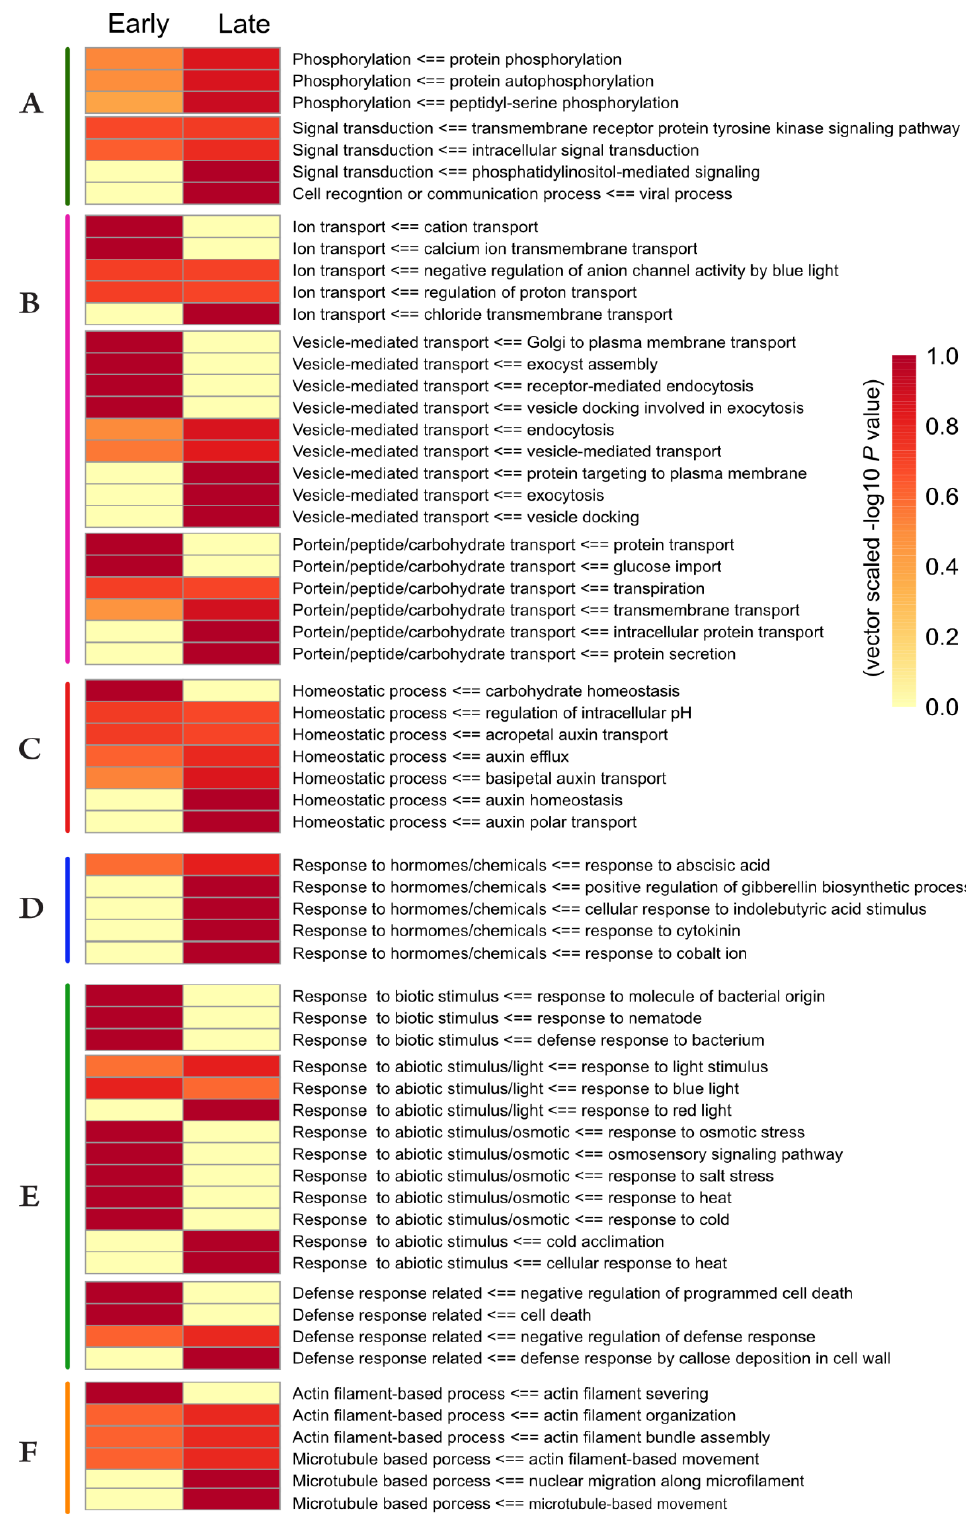
Figure 4. Gene ontology overrepresentation of biological processes (GOBP) for the phosphorylated proteins under cold exposure. Negative log 10 p -values of the GO terms enriched in the K-means clusters mentioned in Figure 2 were vector scaled and visualized. Sub-clusters ( A – F ) are based on the similarity of the GO terms extracted from ReViGO. Early, GO terms enriched within 5 to 15 min of cold exposure; Late, GO terms enriched within 30 to 60 min of cold exposure.